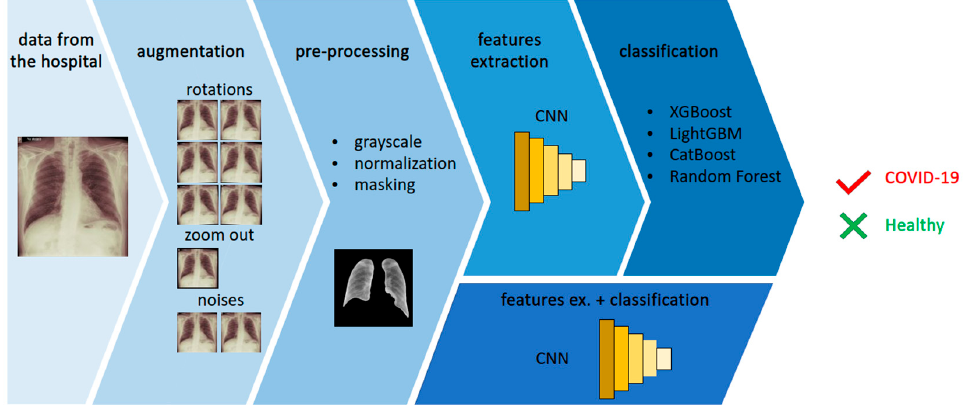
Figure 1. The following steps of processing in the proposed method: data acquisition, data augmentation, sample pre-processing, features extraction and binary classification of COVID-19 as positive or negative (healthy).